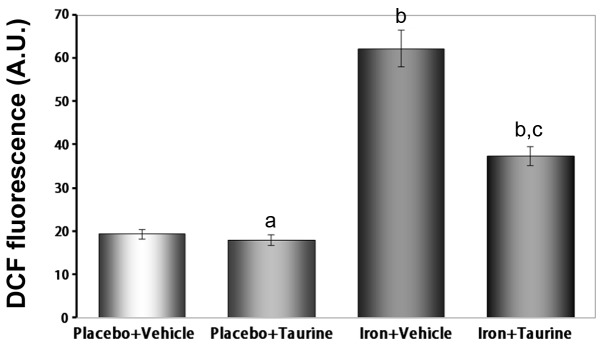
Effects of taurine on hepatic intercellular reactive oxygen species generation in mice injected with iron over a 13-week period. Data are presented as the mean ± standard error of the mean (n=12). aP>0.05 vs. the placebo + vehicle group; bP<0.01 vs. the placebo + vehicle and placebo + taurine groups and cP<0.01 vs. the iron + vehicle group. DCF, dichloro-dihydro-fluorescein.